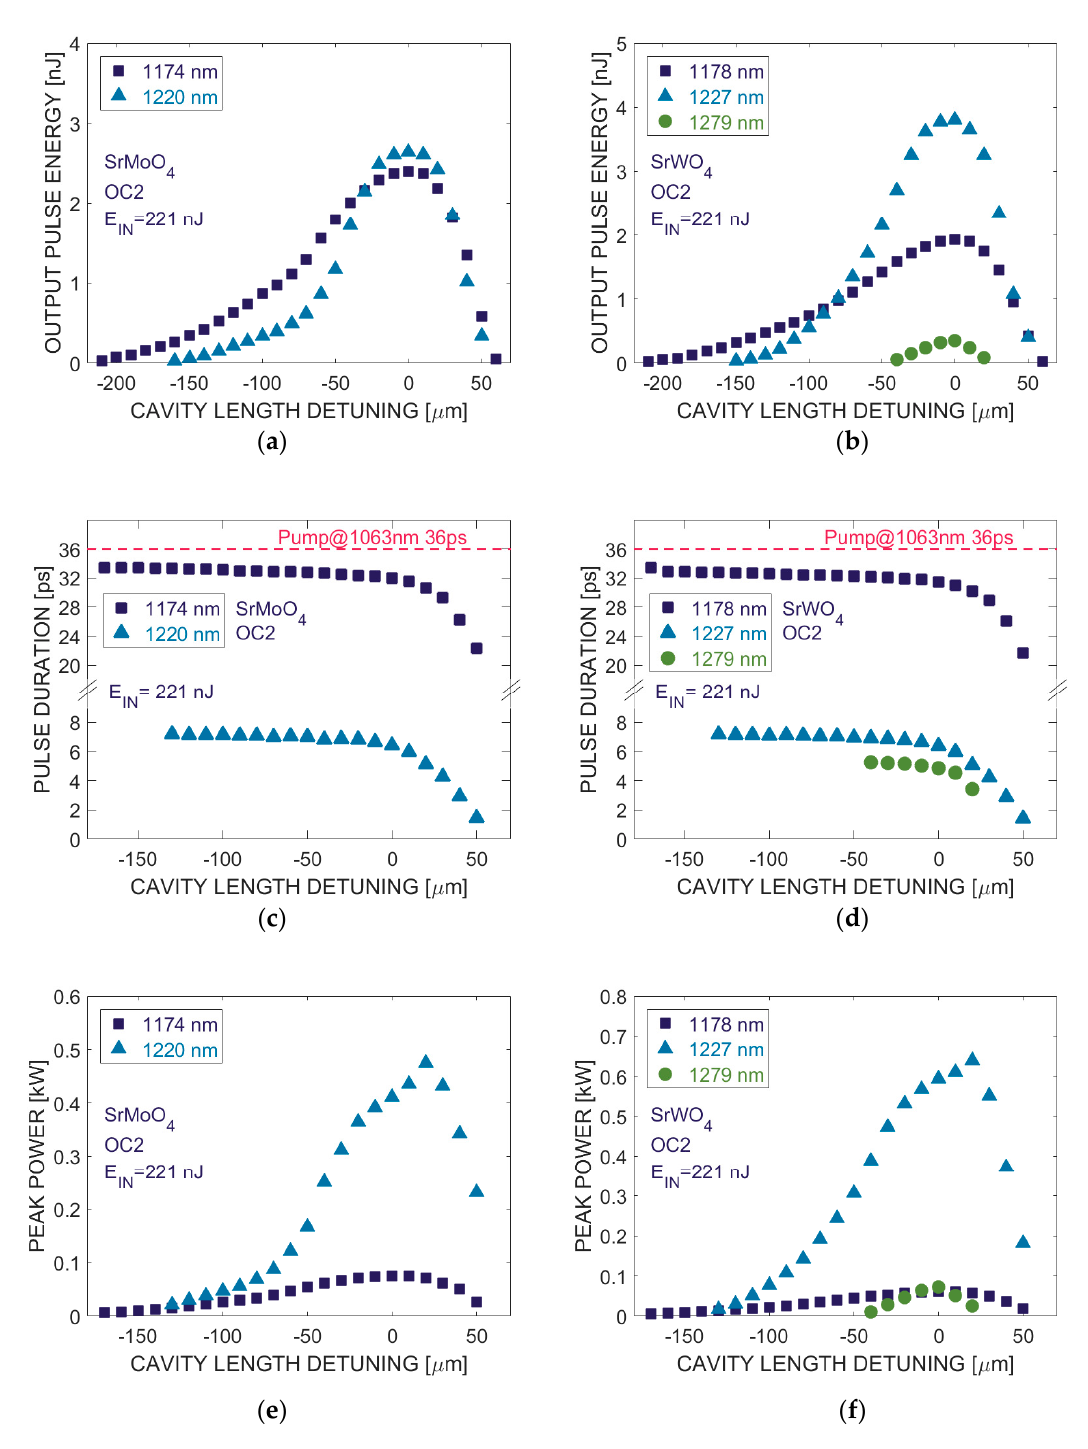
Figure 8. The dependences of the output pulse energy ( a , b ), the output pulse duration ( c , d ) and the output pulse peak power ( e , f ) on the cavity length detuning for the SrMoO 4 [88] ( a , c , e ) and SrWO 4 ( b , d , f ) lasers at OC2 under pumping with the maximal pulse energy of 221 nJ.